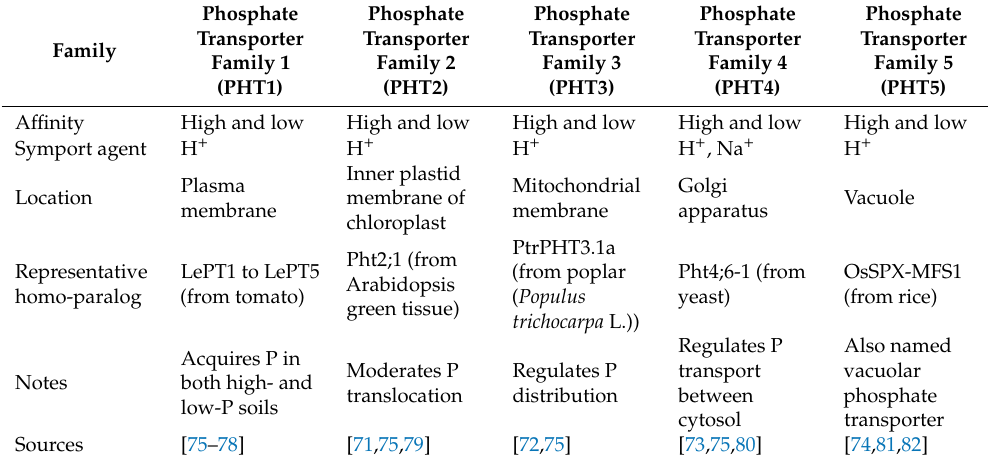
Table 1. Notes on the major phosphate transporter families, PHT1, PHT2, PHT3, PHT4, and